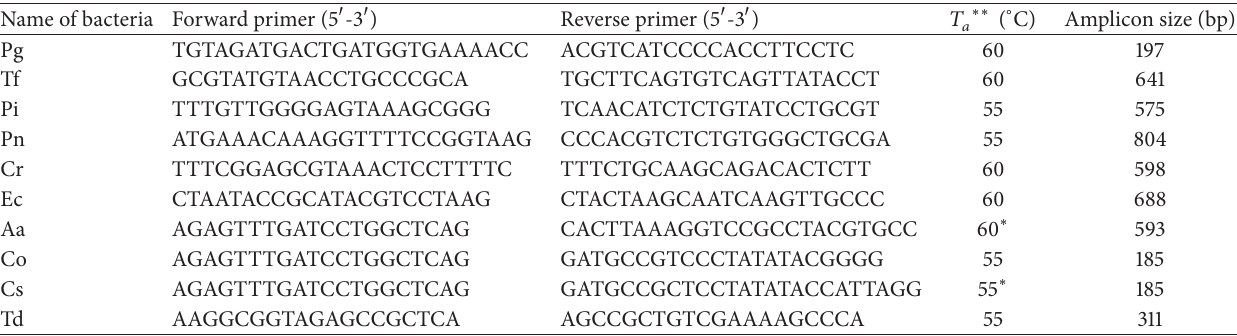
Table 1: Species specific primers used in our study. Name of bacteria Forward primer (5 󸀠 -3 󸀠